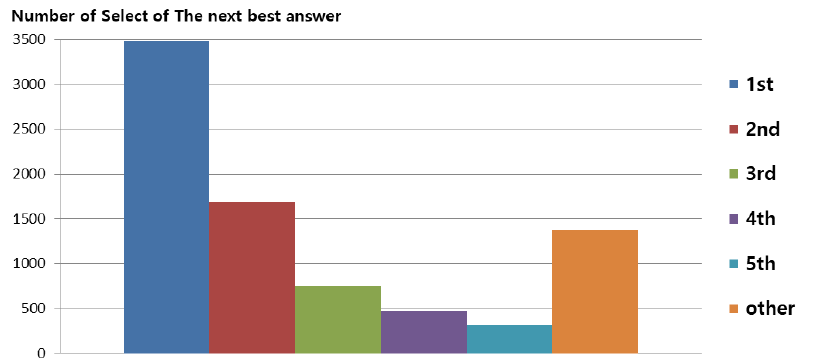
Figure 14. Result of selecting the next best answer.